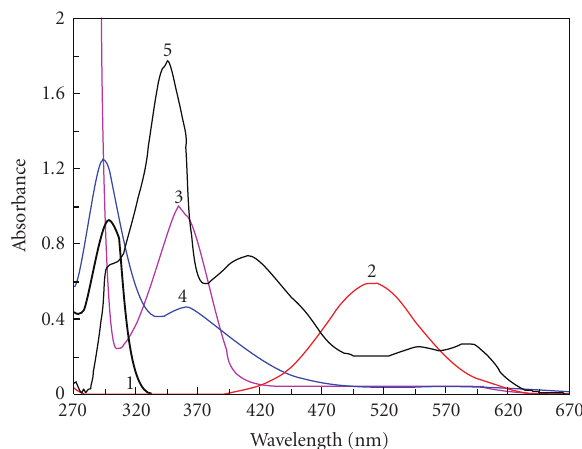
Figure 1: Absorption spectra of OMZ (1), iodine, 0.20 mgmL − 1 in 1,2-dichloroethane (2), DDQ, 0.40mg mL − 1 in acetonitrile (3), OMZ-iodine complex in 1,2-dichloroethane at 25 ± 2 ◦ C (4), and OMZ-DDQ complex in acetonitrile at 25 ± 2 ◦ C (5). Concentrations of OMZ were 30.00, 1.50, and 20 . 00 μ gmL − 1 for the absorption spectra numbers (1), (4), and (5), respectively.